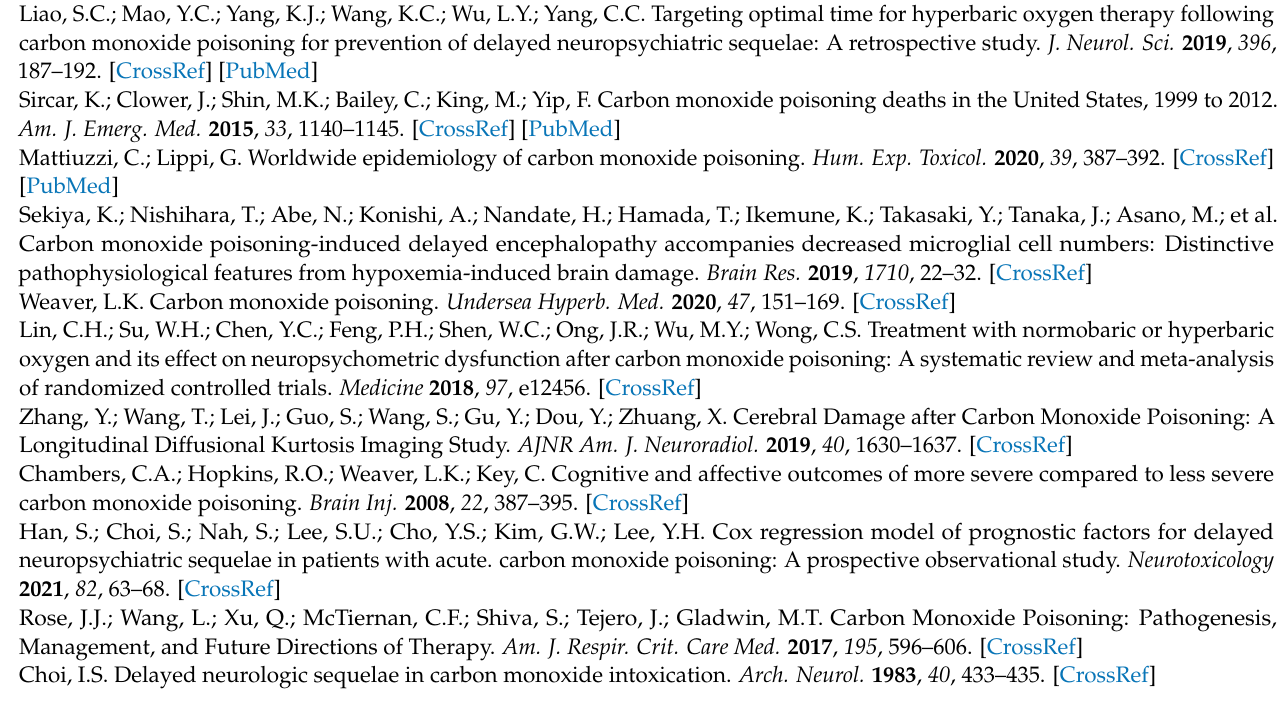
Figure S1: Risk of bias and quality assessment of included studies by the QUIPS tool; Figure S2: Funnel plot for publication